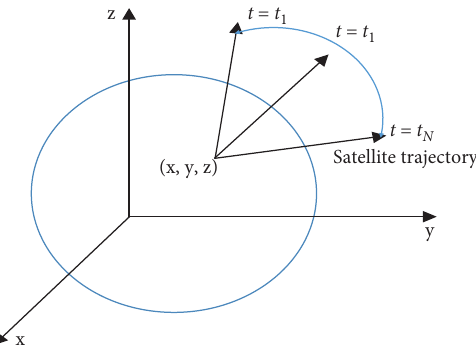
Figure 1: Schematic diagram of a single-star passive positioning